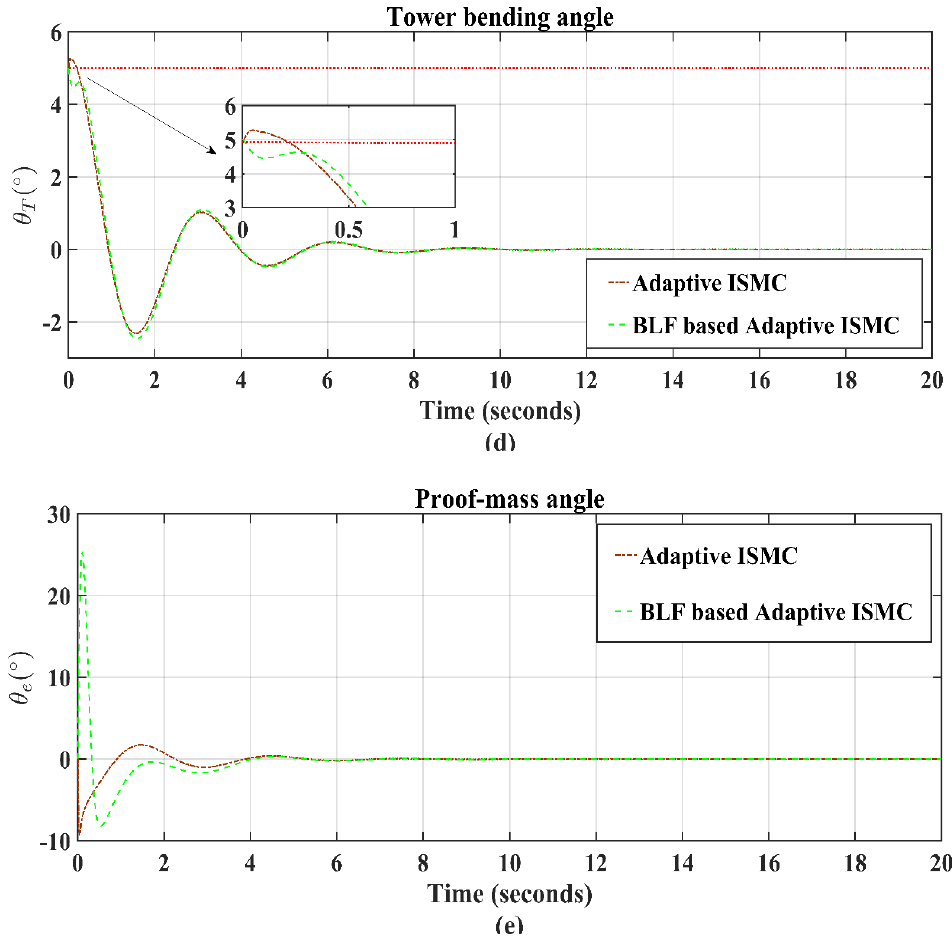
Figure 4. The response of barge − type 5DOF TORA − based OFWT when using adaptive backstepping ISMC and BLF-based adaptive backstepping ISMC, ( a ) X P , ( b ) Z P , ( c ) θ P , ( d ) θ T , and ( e ) θ e , where brown results represent adaptive backstepping ISMC efficiency and green results represent BLF-based adaptive backstepping ISMC efficiency.